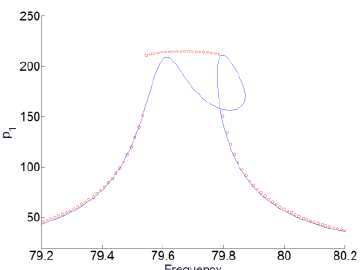
Figure 15. Numerical and analytical responses of p 1 ( t ) for the level of forcing F 1 = 2.01. Red curves with circle stand for numerical results. Blue curves stand for analytical results.